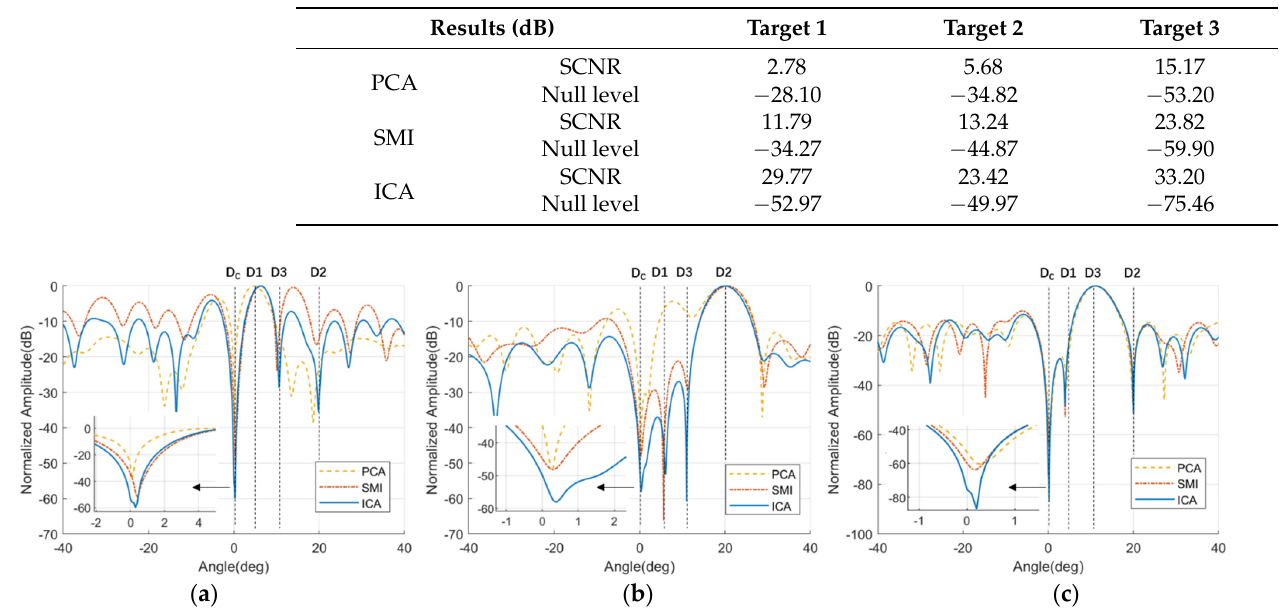
Figure 8. The ICA beampatterns corresponding to the three targets together with the equivalent beampatterns of PCA and the adaptive beampatterns of SMI; the DOAs of the targets and clutter are displayed with black dashed lines, Dc, D1, D2, and D3 represent the DOAs of the clutter, Target 1, Target 2, and Target 3, respectively: ( a ) Target 1 ′ s beampattern; ( b ) Target 2 ′ s beampattern; ( c ) Target 3 ′ s beampattern.